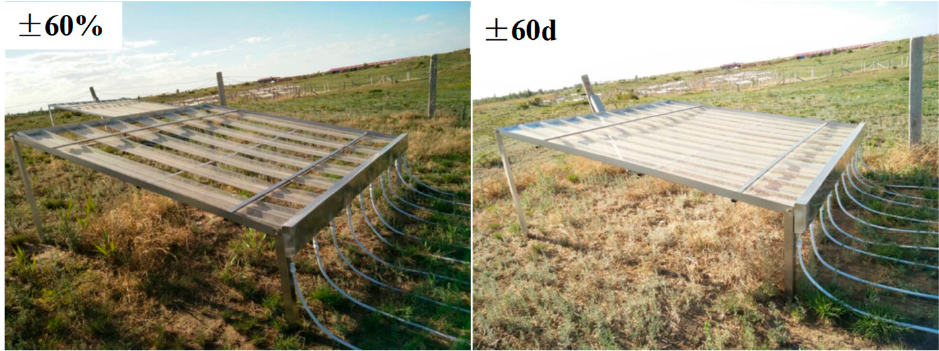
Figure 2. The rainfall-controlled devices used to increase and decrease rainfall.